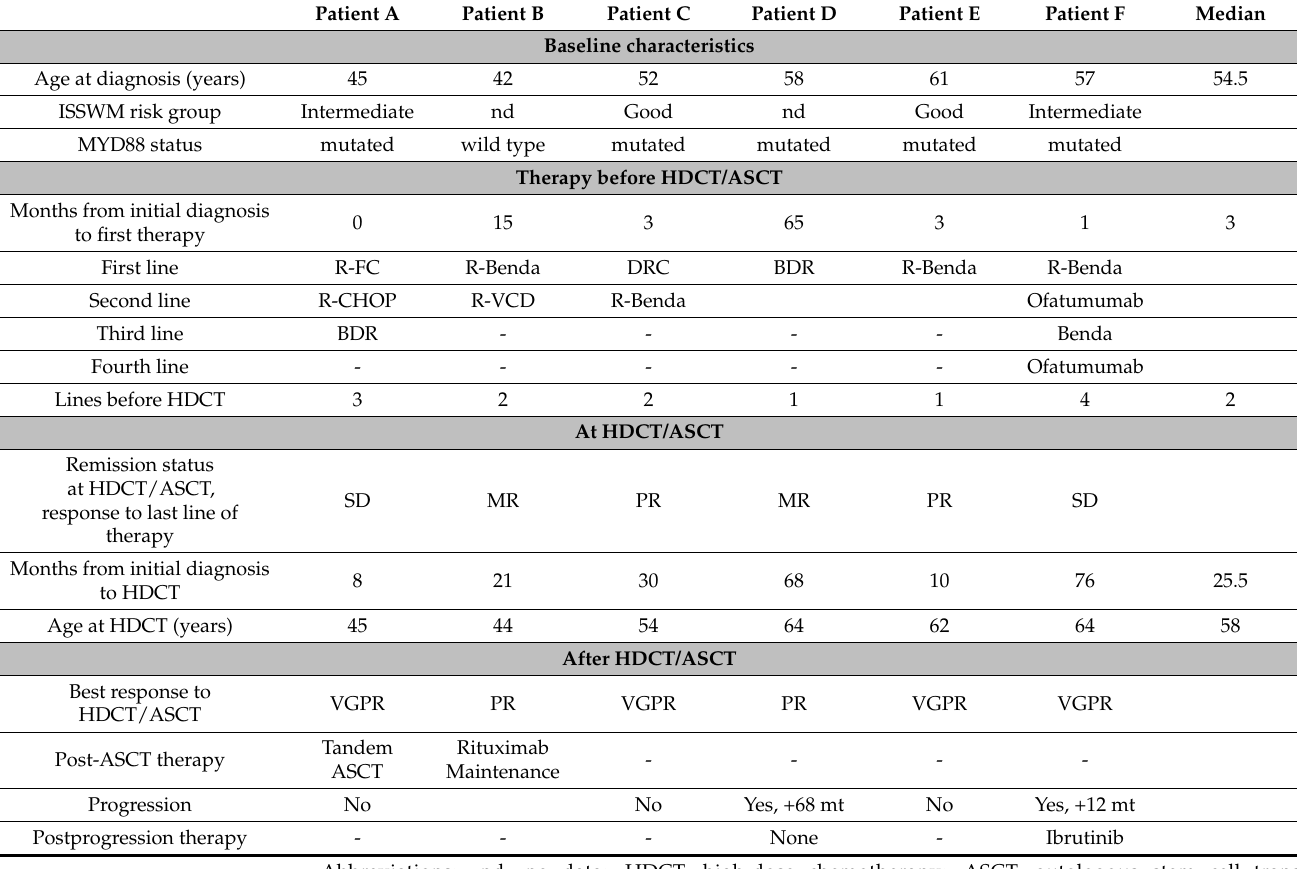
Table 1. Summary of patient’s baseline characteristics, therapy before HDCT/ASCT, and response to